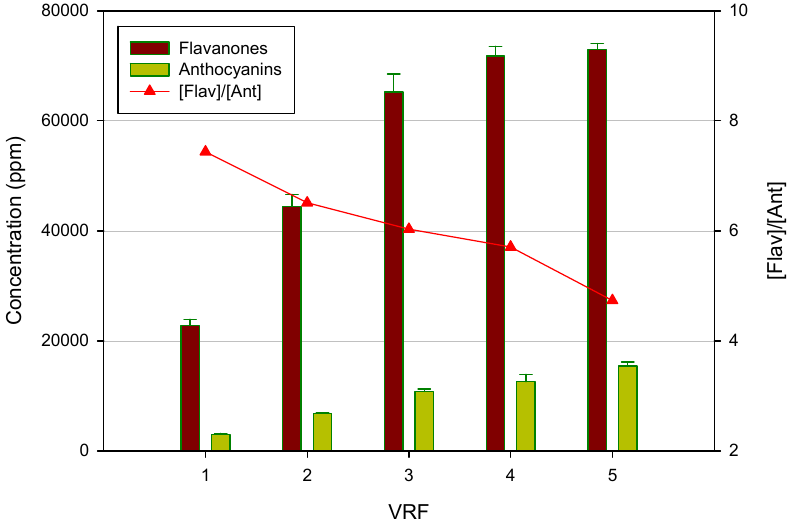
Figure 5. Concentration of flavanones and anthocyanins in the NF retentate as a function of VRF.